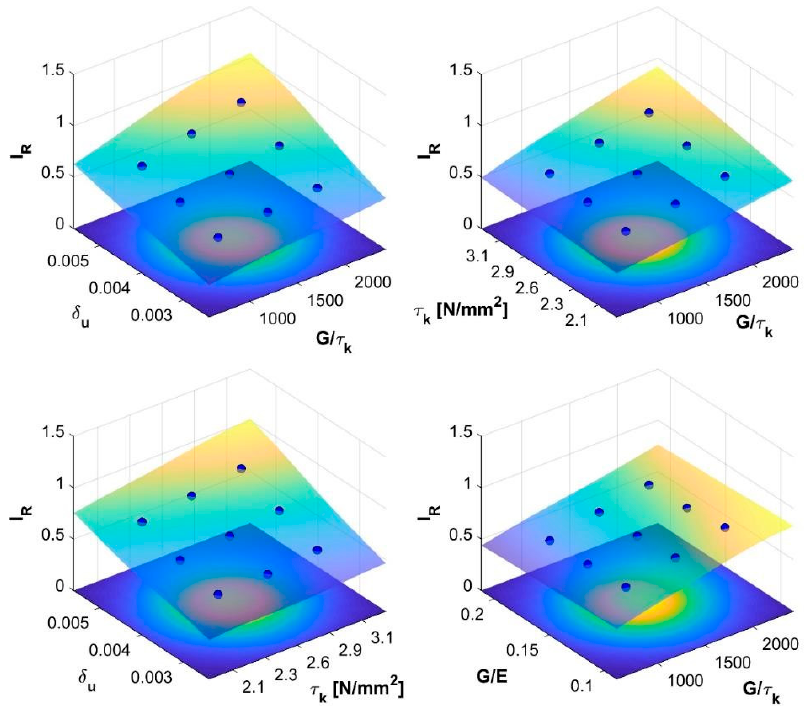
Figure 10. Response surfaces for the seismic risk index I R (Building 1).